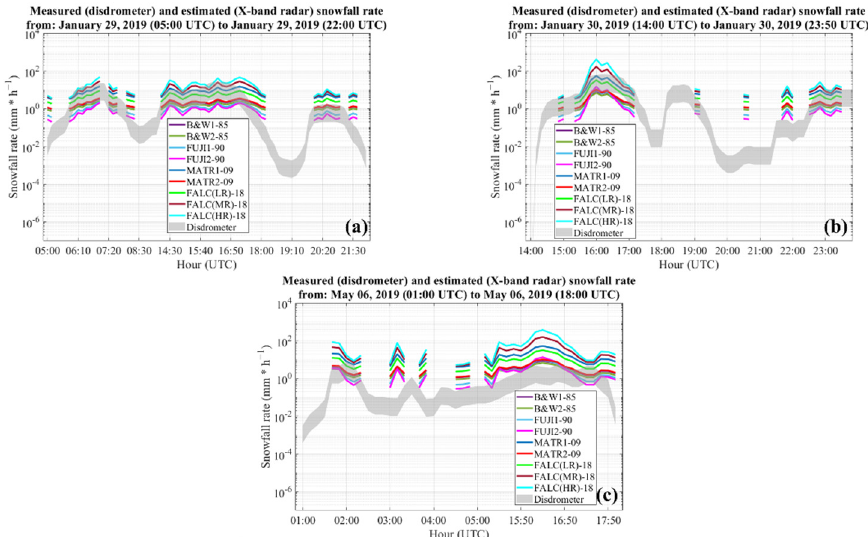
Figure 8. Comparison between measured (from Montevergine disdrometer) and estimated (from X-band radar composite) snowfall rate (in mm · h − 1 ) for three different events: ( a ) 29 January 2019 (from 05:00 to 22:00 UTC), ( b ) 30 January 2019 (from 14:00 to 23:50 UTC) and ( c ) 6 May 2019 (from 01:00 to 18:00 UTC). The nine radar-based algorithms tested in this study are marked by different colors according to the legends shown on each panel, whereas the measured snowfall rate is highlighted by a grey bar. The latter shows the variability of snowfall rate depending on the riming factor (unrimed: low side of the bar; heavily rimed: upper side of the bar).